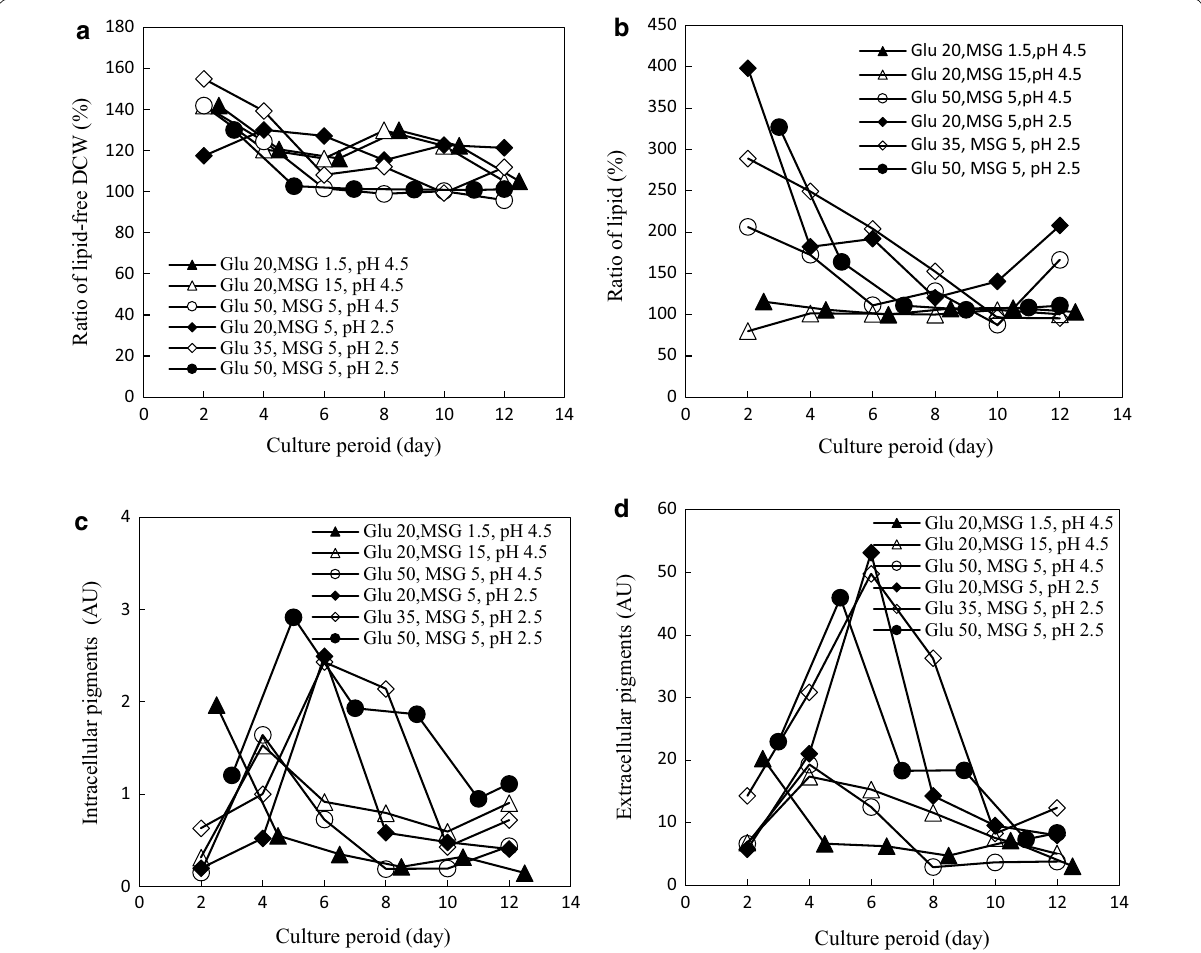
Fig. 2 Cell suspension culture with mycelia collected from different cultivation conditions. a Change of biomass, defined as the ratio of lipid-free DCW after and before determination of mycelia bioactivity; b change of lipid content, defined as the ratio of lipid content after and before deter- mination of mycelia bioactivity; c intracellular Monascus pigments concentration, normalized to biomass concentration of 10 g lipid-free DCW per liter; d extracellular Monascus pigments concentration, normalized to biomass concentration of 10 g lipid-free DCW per liter. The data are average of triplicates. For clear vision, no error bar was